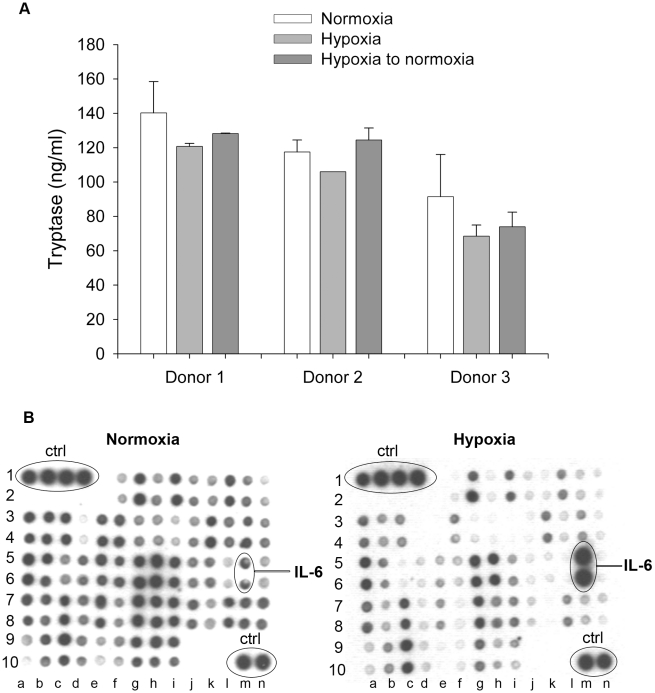
Mast cell mediator release.
A Mast cell tryptase release before or after hypoxia, three different donors, n = 3, mean ± SEM. B Antibody array: Protein secretion in response to normoxia and hypoxia. The identity of some of the proteins included in the array is indicated. A complete description of the array is found in Table 1.